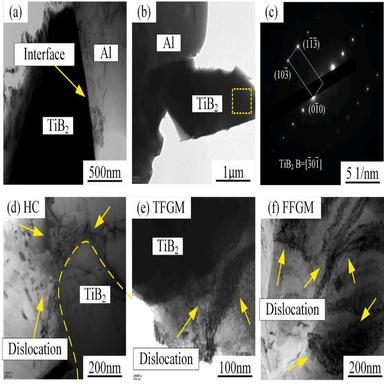
TEM micrographs bright fields of TiB2/Al7050 composites: (a) Interface of the sintered-state composites; (b) Morphology of TiB2; (c) SAED of TiB2 phase; Dislocations distribution in different composites after bending deformation: (d) HC; (e) TFGM; (f)FFGM.